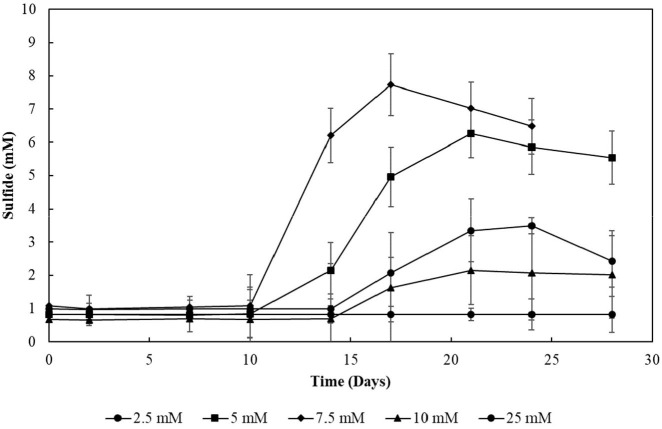
Evolution of sulfide production in cultures incubated with increasing sulfite concentrations. Measurements of biological triplicates were averaged, and the standard deviation is shown.